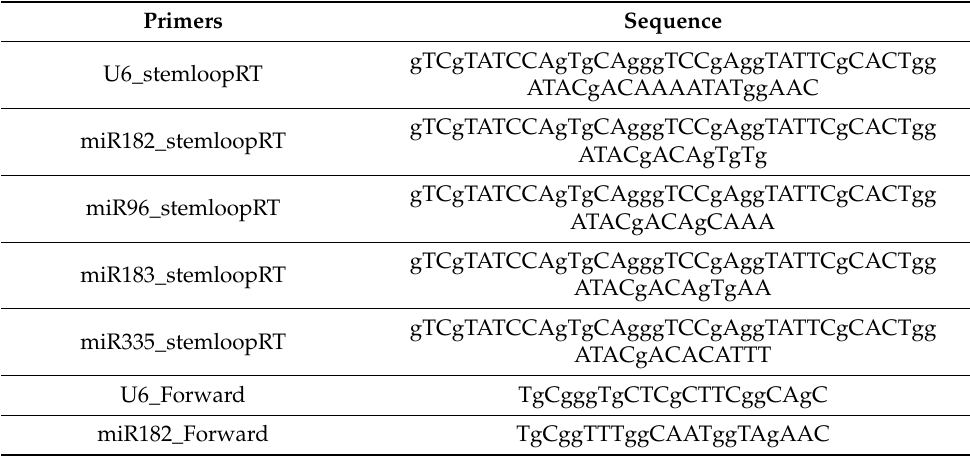
Table 1. The sequences of primers used for qPCR